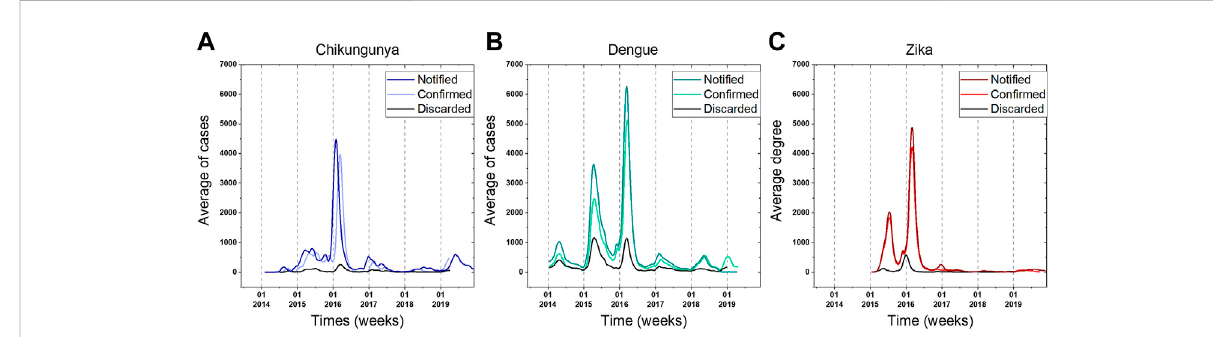
FIGURE 4 Time evolution of the 7-week average number of noti fi ed, con fi rmed and discarded cases. (A) Chikungunya. (B) Dengue. (C) Zika. The vertical grid lines highlight the beginning of a new year.